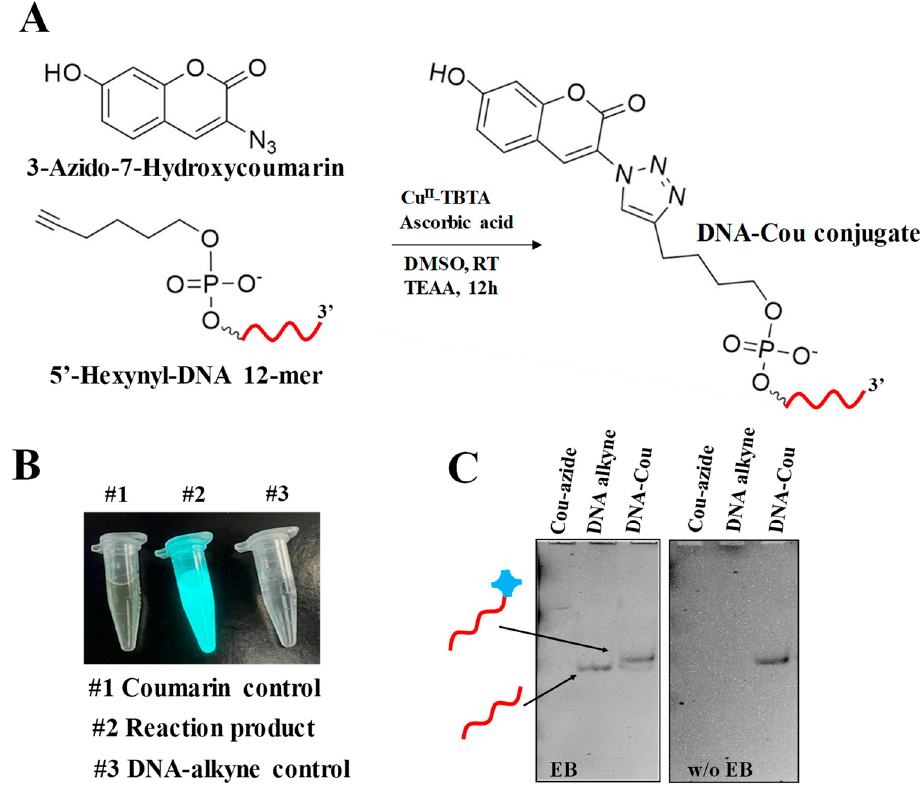
Figure 1. Coupling of ODN alkyne with coumarin azide utilizing “click” chemistry and product analysis. ( A ) Generalized reaction diagram interaction between 3-azido-7-hydroxycoumarin and 5 ′ -Hexynyl-DNA in a 2:1 ratio in the presence of Cu(I) catalyst. ( B ) Irradiation of the DNA-Cou conjugate product and control samples by UV lamp 365 nm. ( C ) Denaturing 32% PAGE demonstrating band shifts between DNA alkyne (reactant) and DNA-Cou (product).